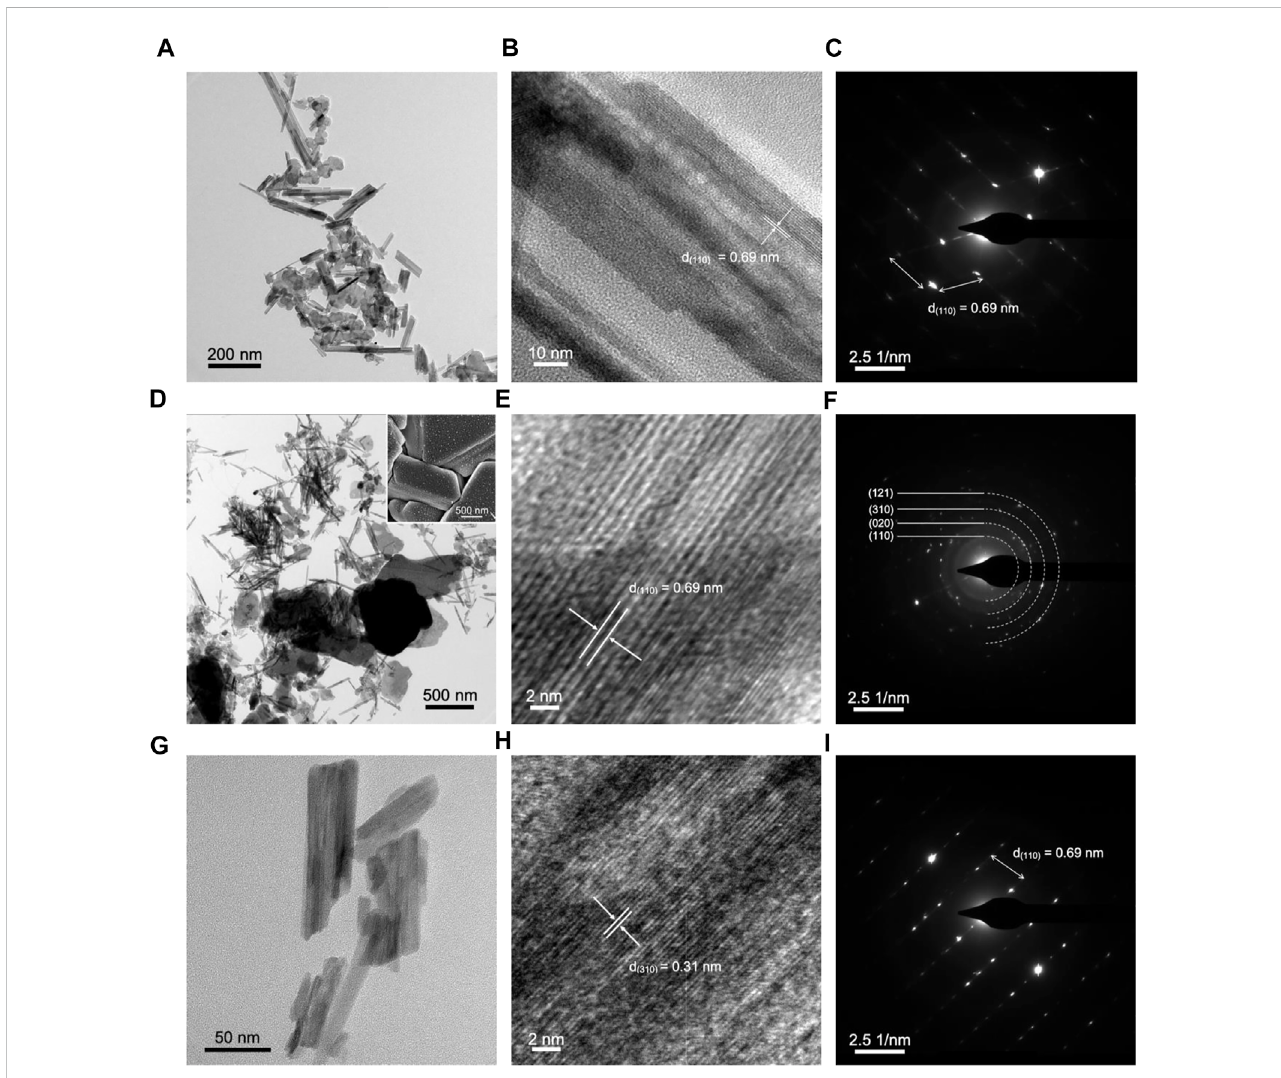
FIGURE 5 TEM, HRTEM, and SAED pattern images of MnO 2 cathode (A – C) before cycling, (D – F) after discharge, and (G – I) after charge. Inset of SEM image of cathode after discharge.